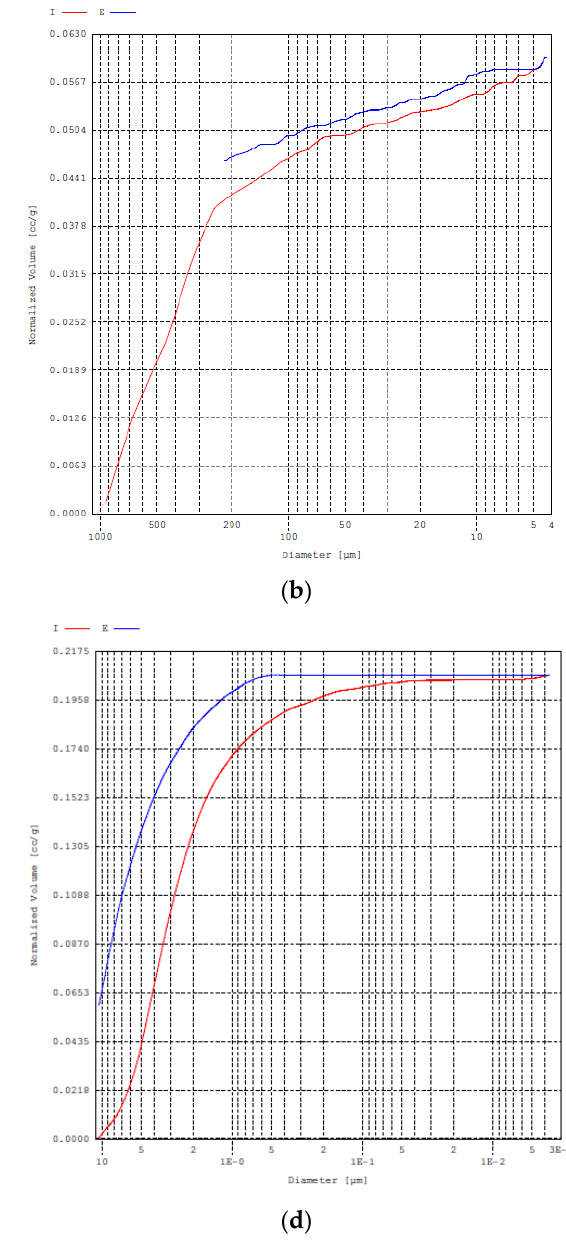
Figure 12. The normalized volume of mercury vs. pore size in low and high pressure. Intraparticle porosity is shown in red and interparticle one in blue: ( a ) Reference at low pressure; ( b ) MBC-0.4 at low pressure; ( c ) Reference at high pressure; ( d ) MBC-0.4 at high pressure.